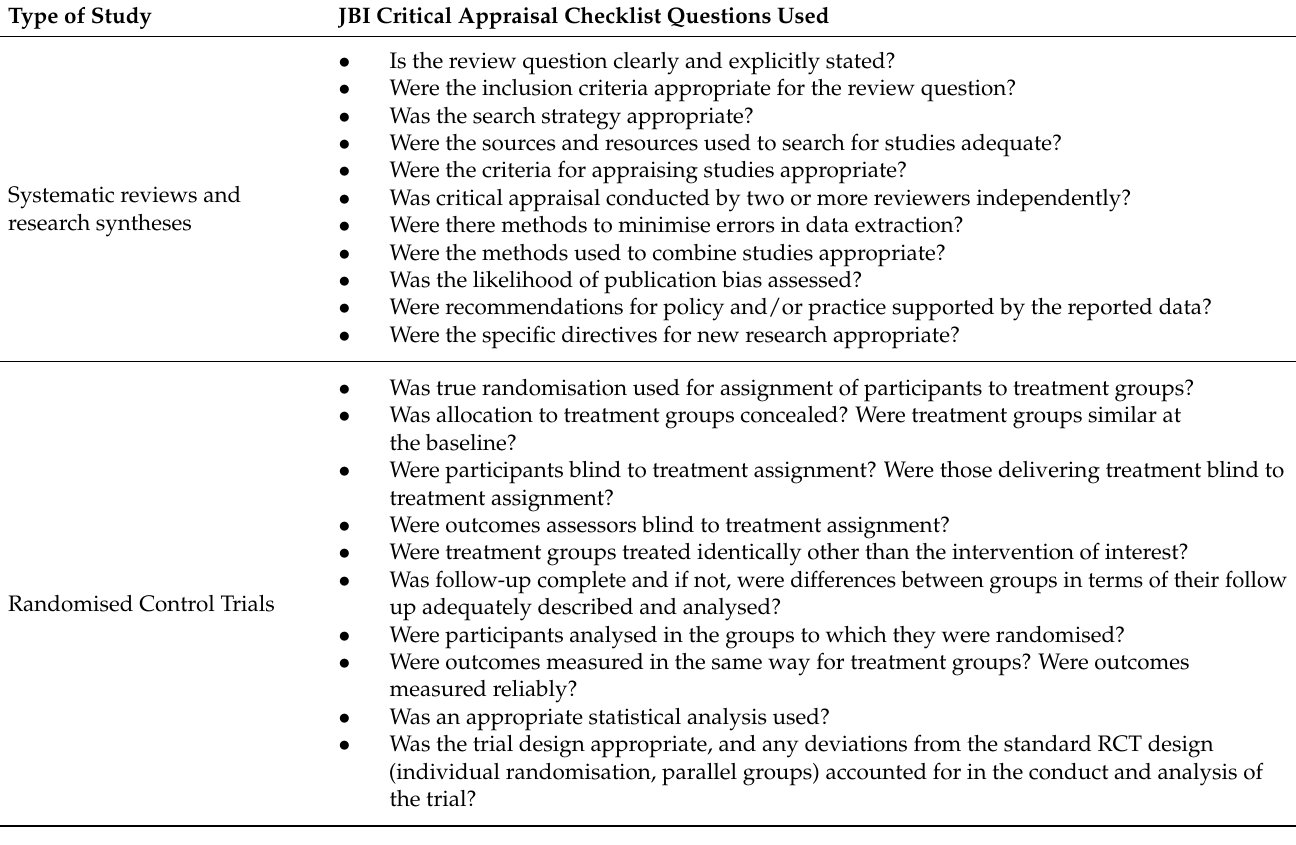
Table 2. Quality assessment checklist of the included articles adapted from JBI